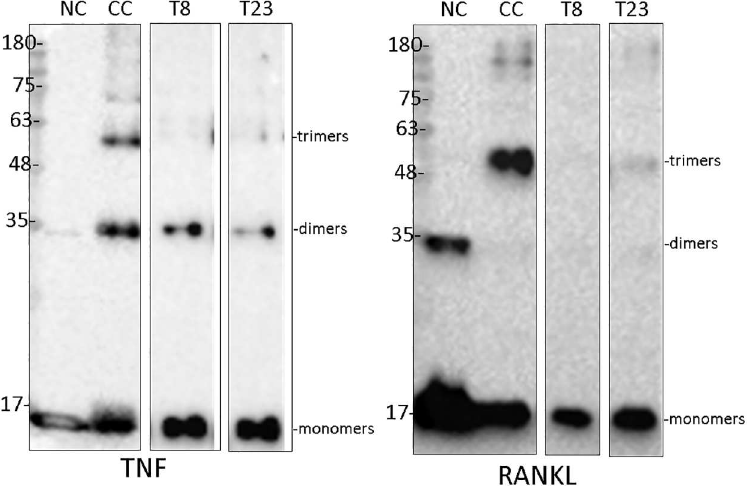
Fig 7. T8 and T23 obstruct the formation of active TNF and RANKL trimers. Human TNF or RANKL was incubatedwith T8 or T23, chemicallycross-linked, and subjectedto SDS-PAGE. This was followedby western blottingto detect the various TNF and RANKL multimers. Both inhibitorswere used at a molar ratio of 4:1 relativeto TNF and 1:1 relativeto RANKL. Numbers indicatemolecularweightsin kDa; NC = non cross- linkedcontrol (no inhibitor,no cross-linking); CC = cross-linkedcontrol (no